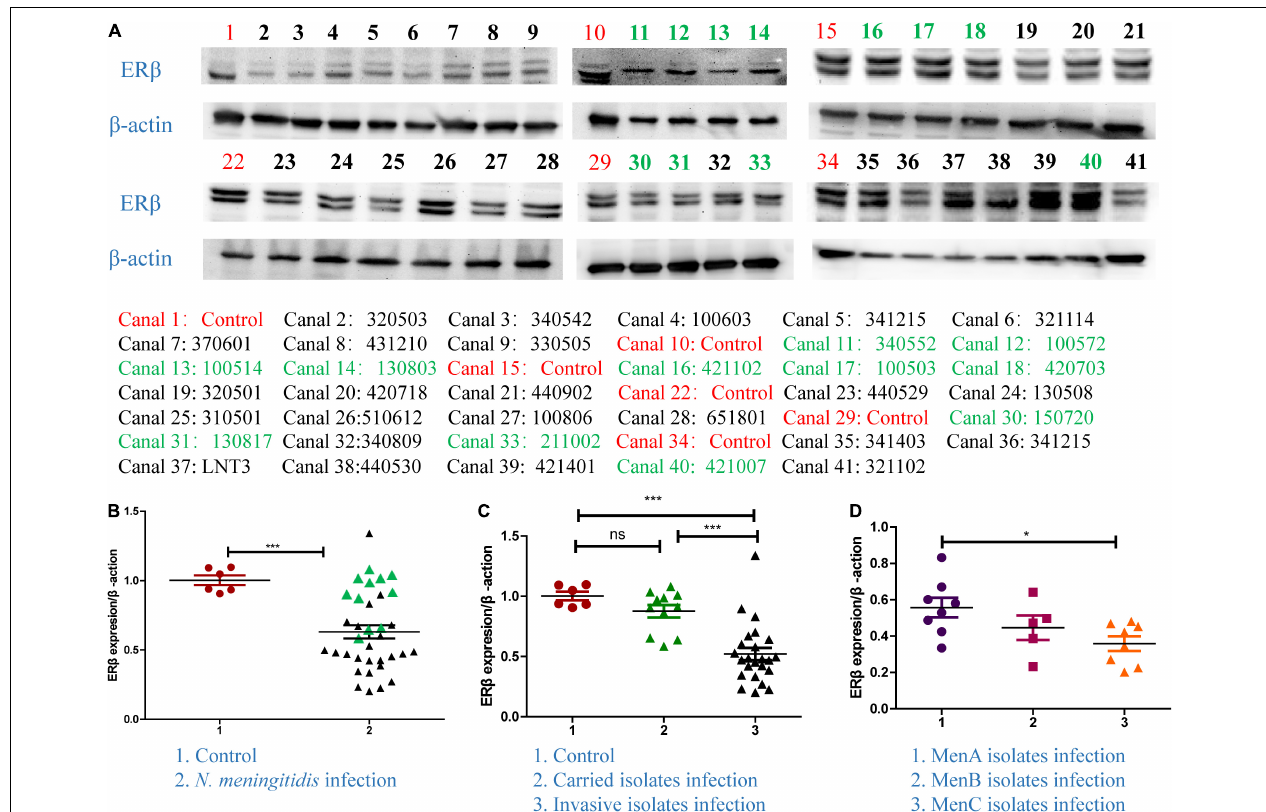
FIGURE 1 | The expression of ER β in Neisseria meningitidis -infected cells. (A,B) Thirty-five N. meningitidis isolates were collected from China CDC, and host cells were infected with the N. meningitidis isolates. The proteins of the 35 infected-cells were extracted, and the cellular proteins of uninfected N. meningitidis as the control group (CTR) were extracted. Isolates ID with black color represented invasive isolates. Isolates ID with green color represented invasive isolates. Western blotting assays were used to detect the levels of ER β in host cells after infection with N. meningitidis . *** P < 0.001. (C) Graph-pad Prism software further analyzed the levels of ER β in the control group, the carrier isolates infection group, and invasive isolates infection group. Ns, not-significant, *** P < 0.001. (D) The above software was used to analyze the changes of ER β levels in host cells after infection with serogroup A, B, and C invasive isolates. * P <